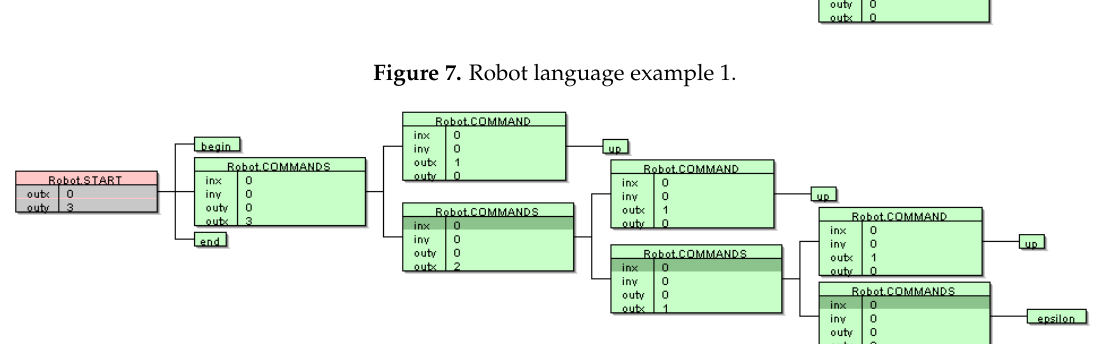
Figure 8. Robot language example